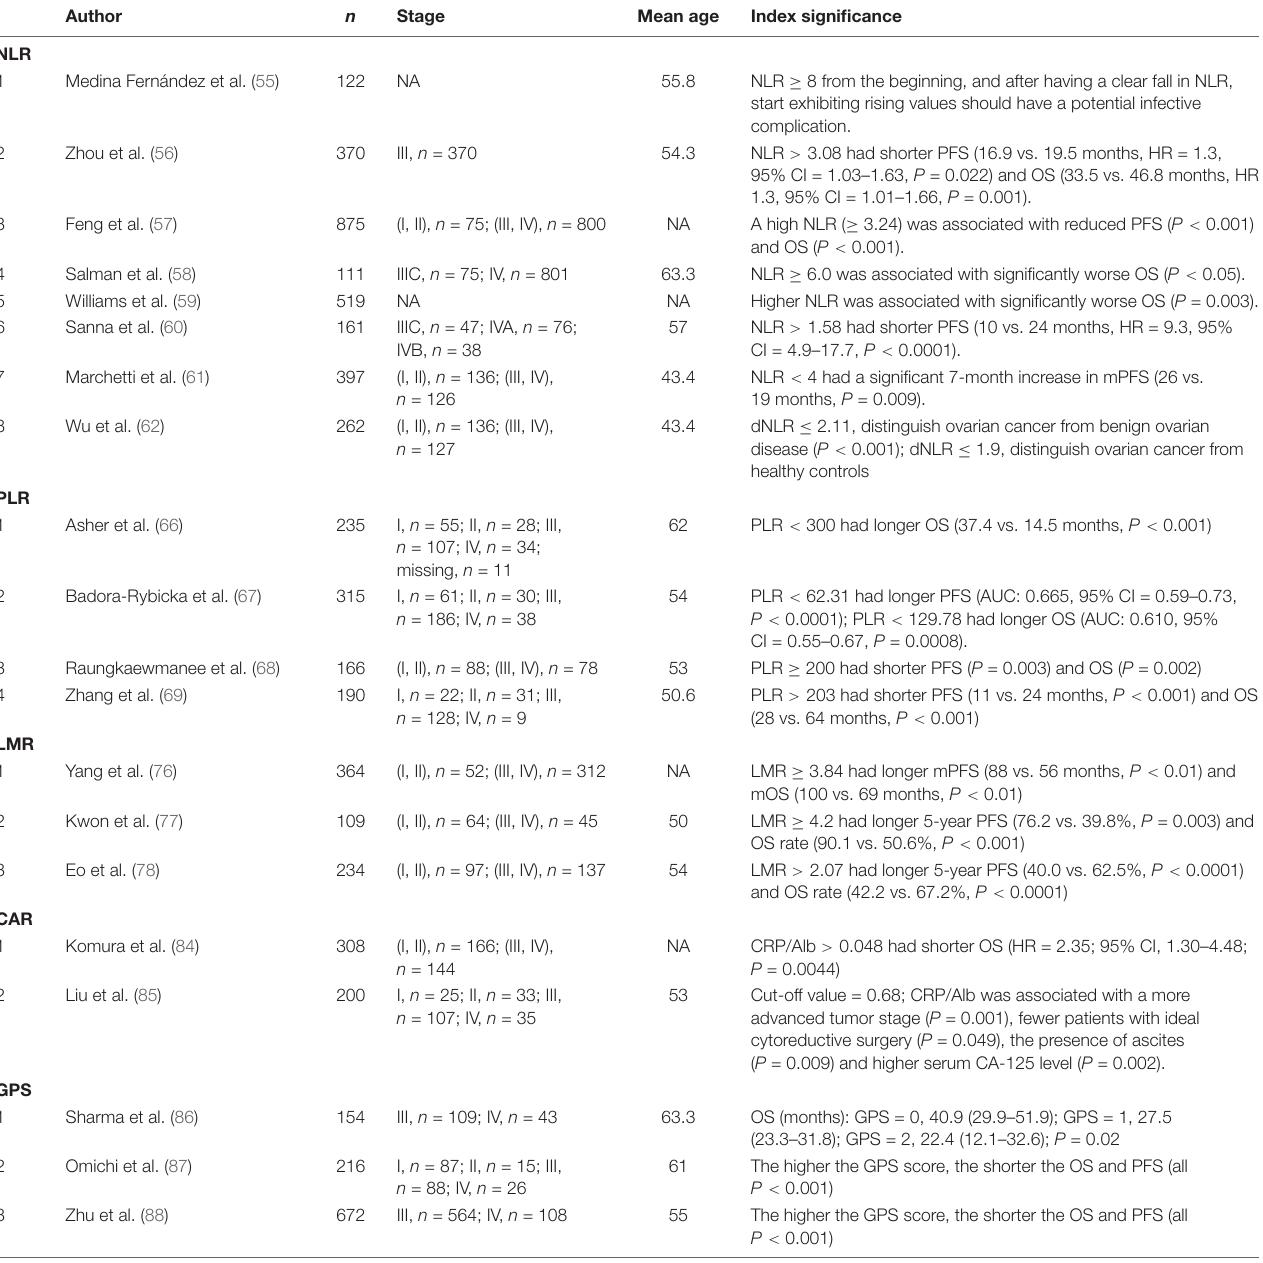
TABLE 3 | Relationship between inflammatory markers and